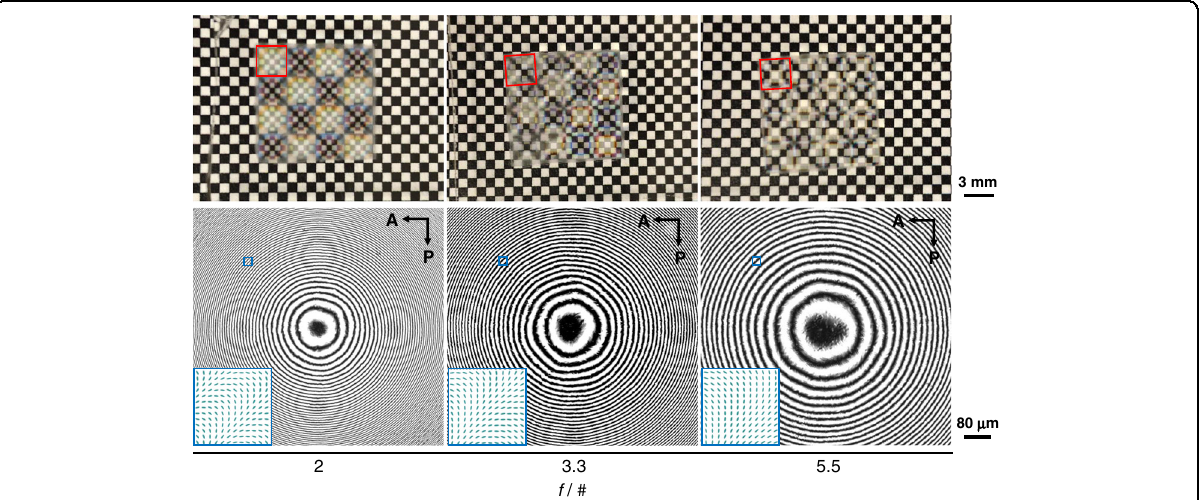
Fig. 2 Characterization of fabricated polymerized LC POEs. Top row: Optical images of 4-by-4 arrays of fabricated f /2, f /3.3, f /5.5 POEs. The POEs are placed 6-mm away from the checkerboard background. The imaging effect of POEs can be clearly identi fi ed. The red squares highlight individual POEs. Bottom row: Polarized optical microscope images of the fabricated POEs with various f /#. The POEs are inserted in between two linear polarizers. The intensity modulation demonstrates spatially varying LC alignment. For a POE with a smaller f /#, such spatial variation of LC director distribution is more dramatic. The cyan squares highlight the LC director distribution of the selected area. A analyzer, P